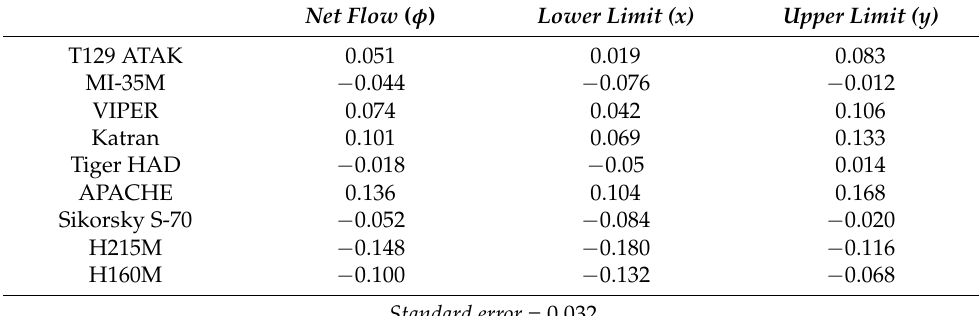
Figure 5. Charts generated by the web platform based in the three models of preference analysis. Table 14. Lower and upper limits for construction of preference analysis by